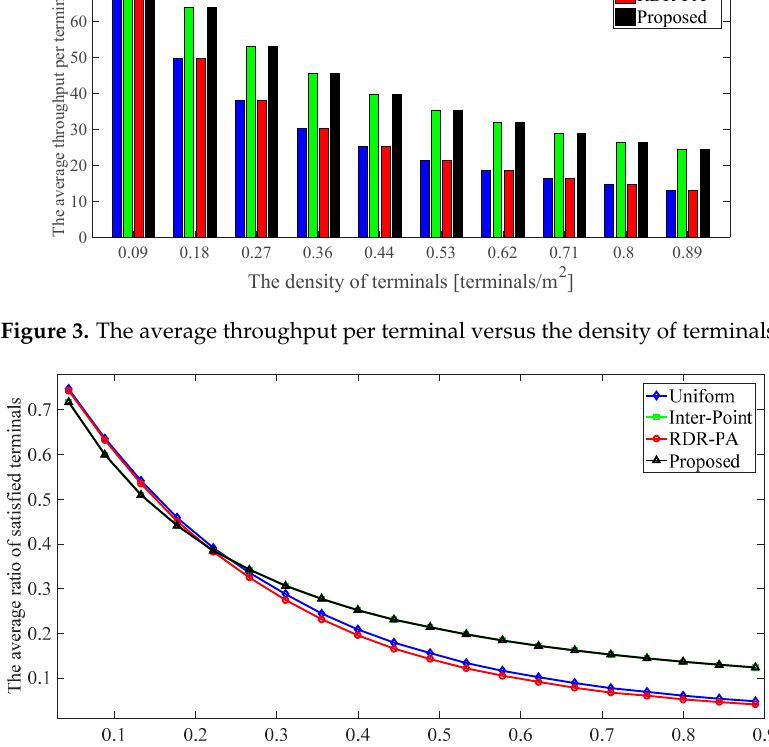
Figure 4. The average ratio of satisfied terminals versus the density of terminals.